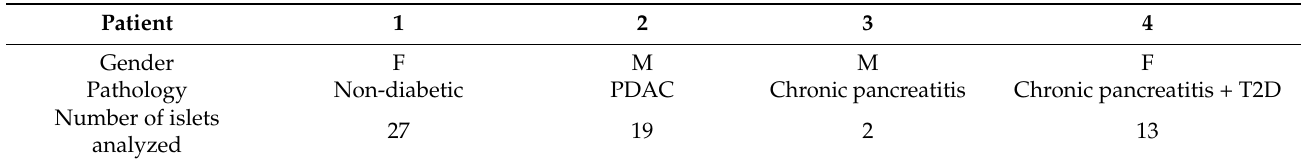
Table 1. Human islets used for FLIM